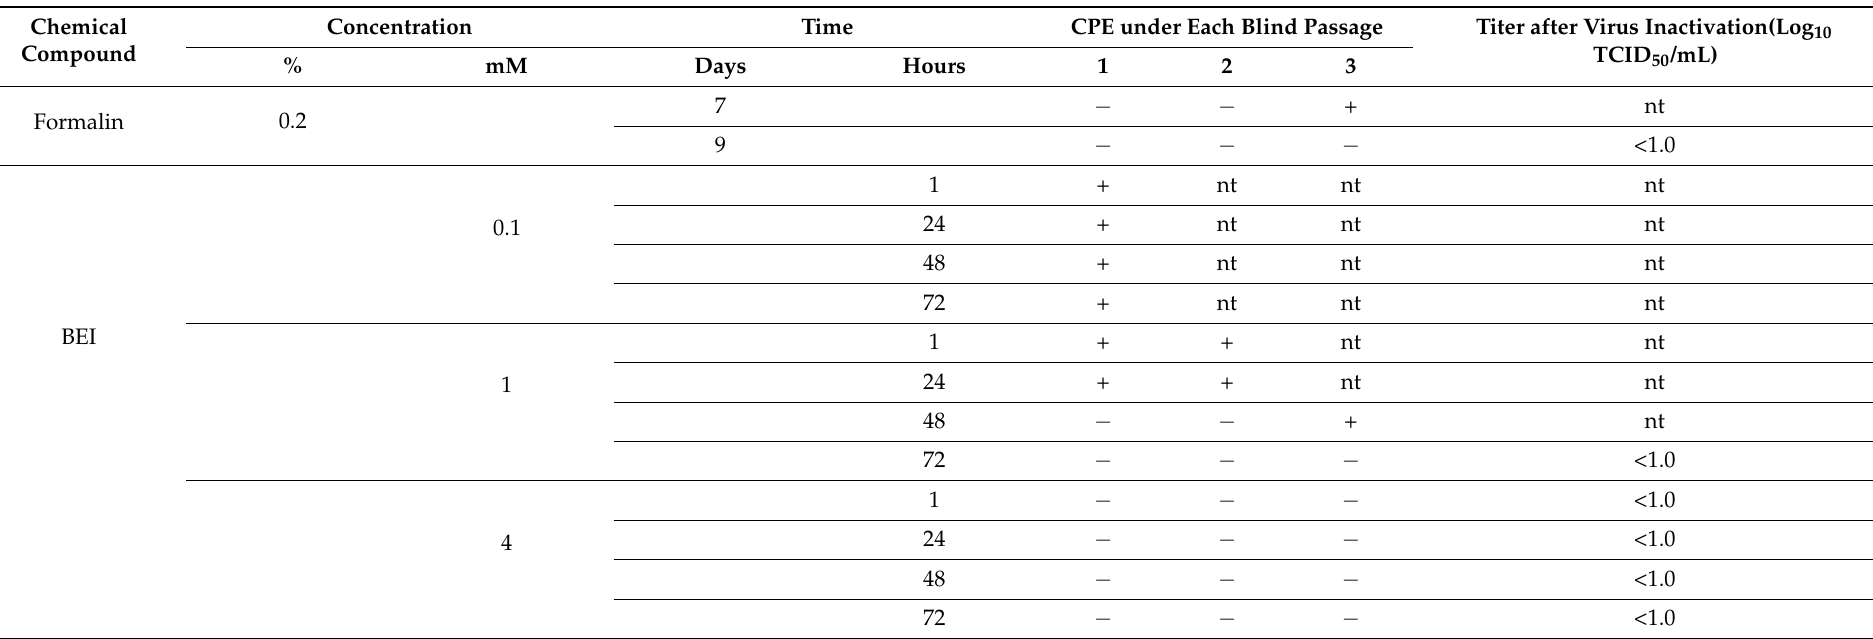
Table 2. Safety test of form- and BEI-iSs160 vaccines after different concentration of chemical compounds treatments and incubation periods. Chemical